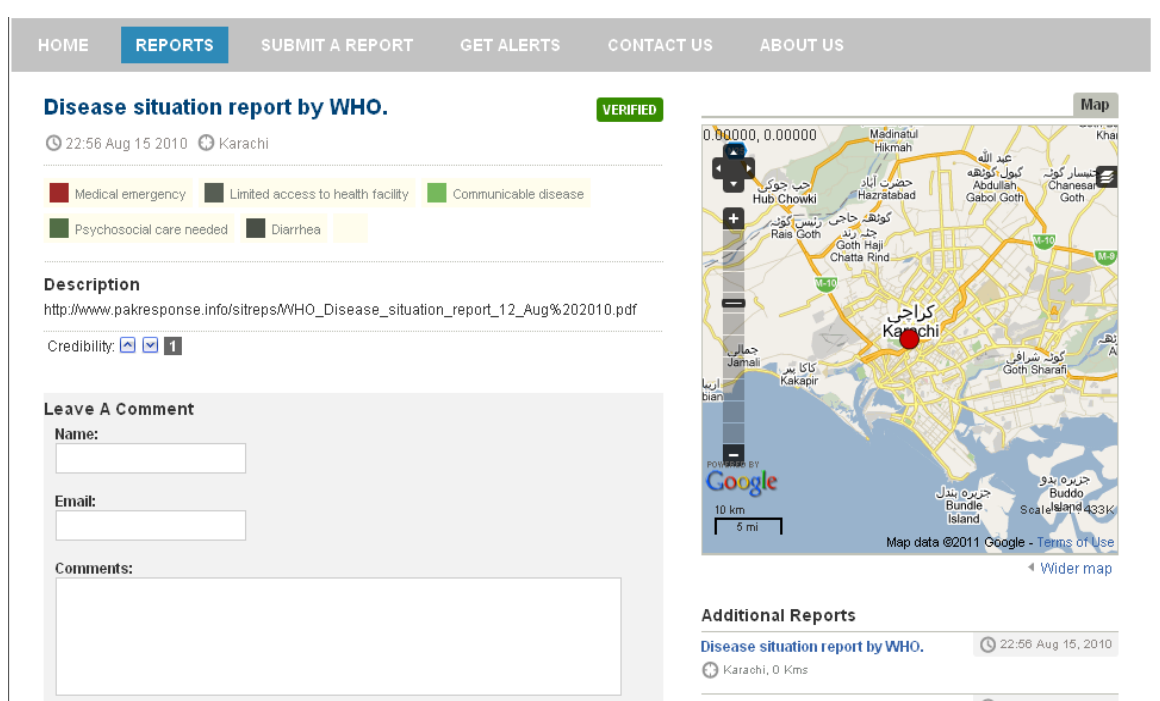
Figure 6. Ushahidi report illustration, from Pakrelief web site